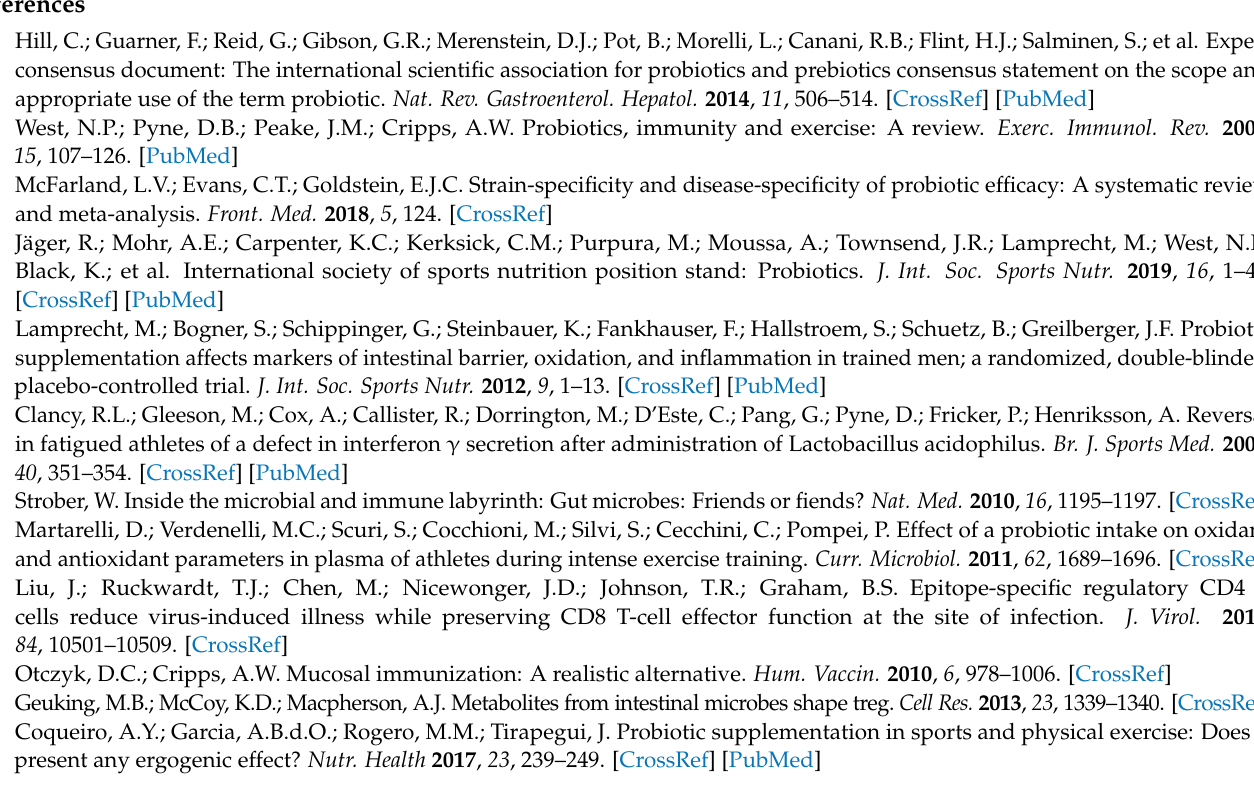
Table S2: the reason of excluded